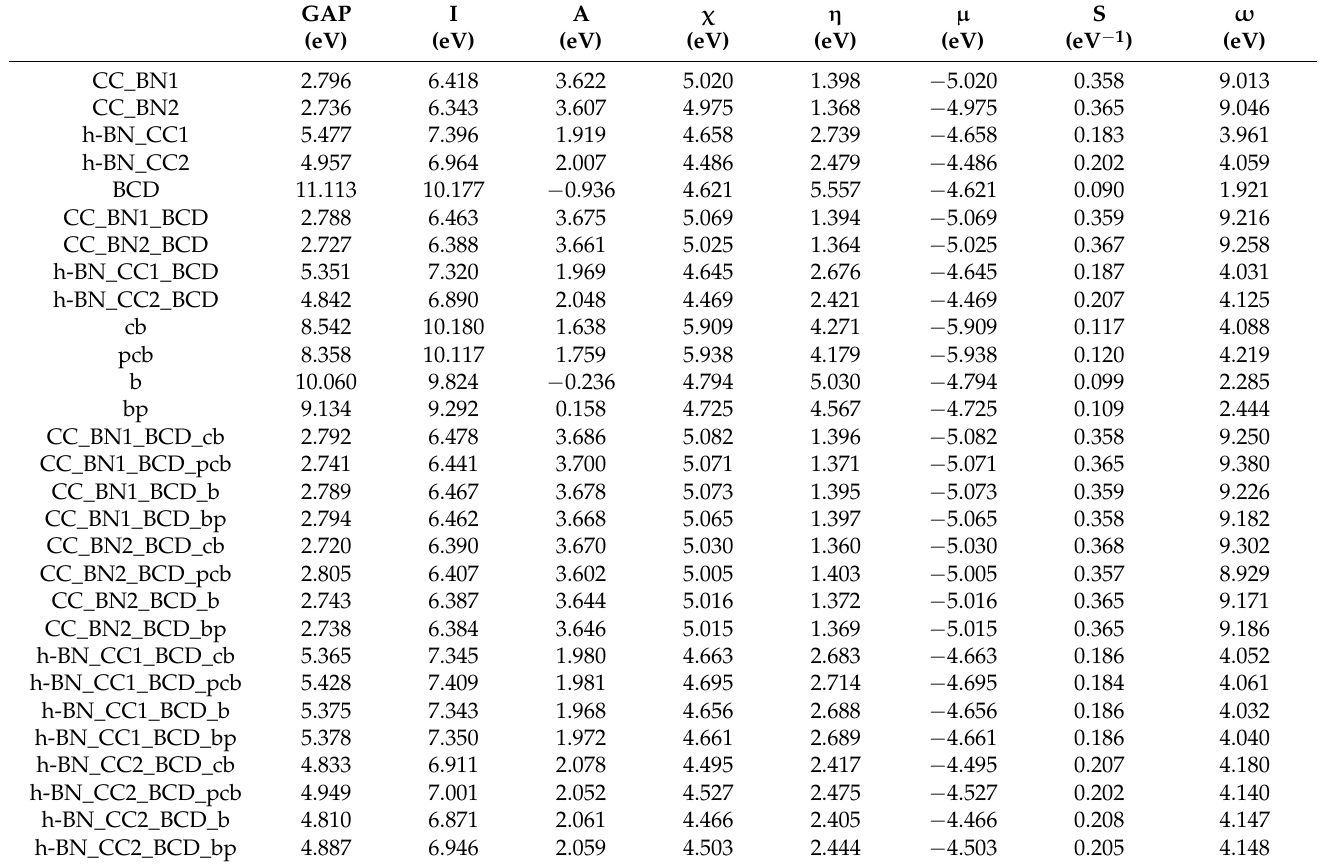
Table 2. The HSAB reactivity descriptors in the present